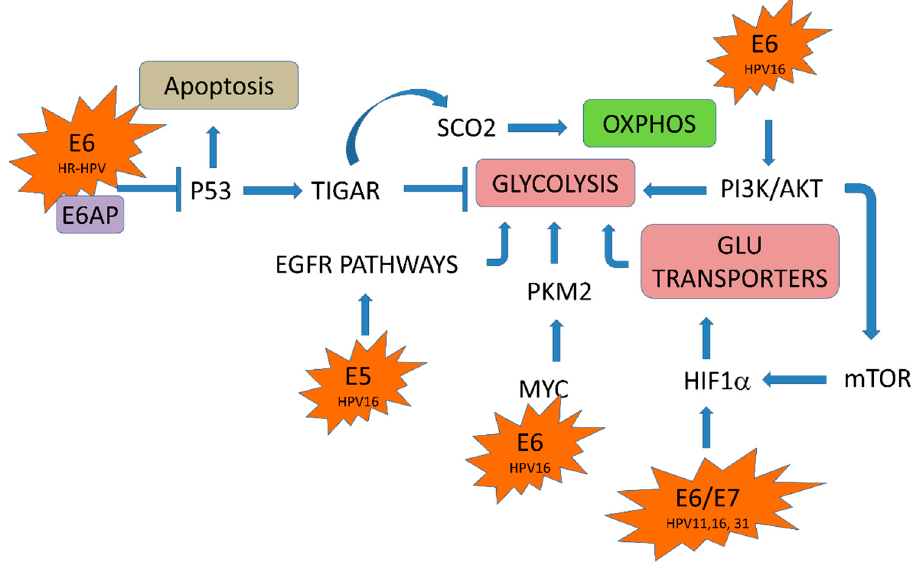
Figure 3. Modulation of the Warburg effect by HPV oncoproteins. E6, E7, and E5 viral proteins activate the glycolytic pathway (arrows). E6 with E6 associated protein (E6AP) inhibits repressors of the glycolytic pathway such as p53, which activates the TP53 induced glycolysis and apoptosis regulator (TIGAR), a glycolytic repressor protein (truncated arrow). TIGAR activates cytochrome c oxidase assembly protein (SCO2), activator of oxidative phosphorylation (OXPHOS). Hence, the absence of p53 promotes glycolysis. E5 activates epidermal grow factor receptor (EGFR) pathways; E6 activates Pyruvate kinase isoform 2 (PKM2), PI3K/AKT and rapamycin complex 1 (mTOR); E6 and E7 activate hypoxia-inducible factor (HIF1. Glu: glucose). The HPV type is indicated.